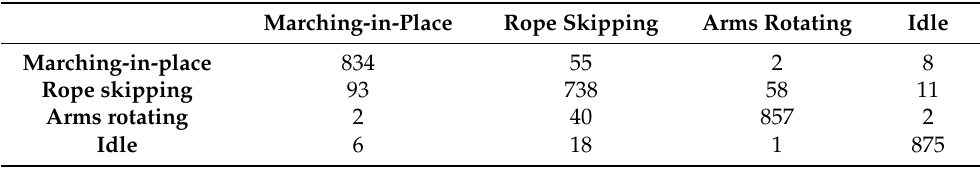
Figure 7. This figure shows the average accuracy of the four categories of WiFi signals. The sensitivity, precision, F1-score, specificity, and accuracy of the classifications are shown in Figure 8. Compared to the other classifiers, using the RF classifier in our method was likely to obtain the best performance in this scenario. The confusion matrix of the classification via the RF classifier is given in Table 1, with the sensitivity, accuracy, and specificity in Table 2. Table 1. The confusion matrix of the classification via the